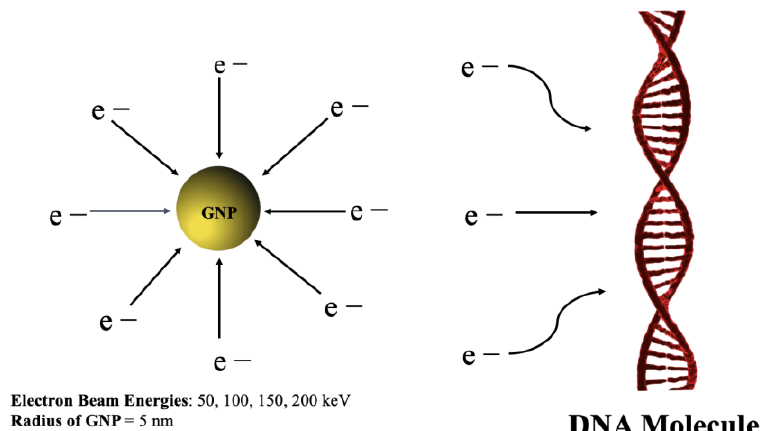
Figure 2. Diagram of a DNA simulation with radial electron beams. Electron beam energies used are equal to 50, 100, 150, and 200 keV. The radius of the gold nanoparticle is 5 nm. This diagram does not represent the exact scale or the ratio between the GNP and DNA molecule.